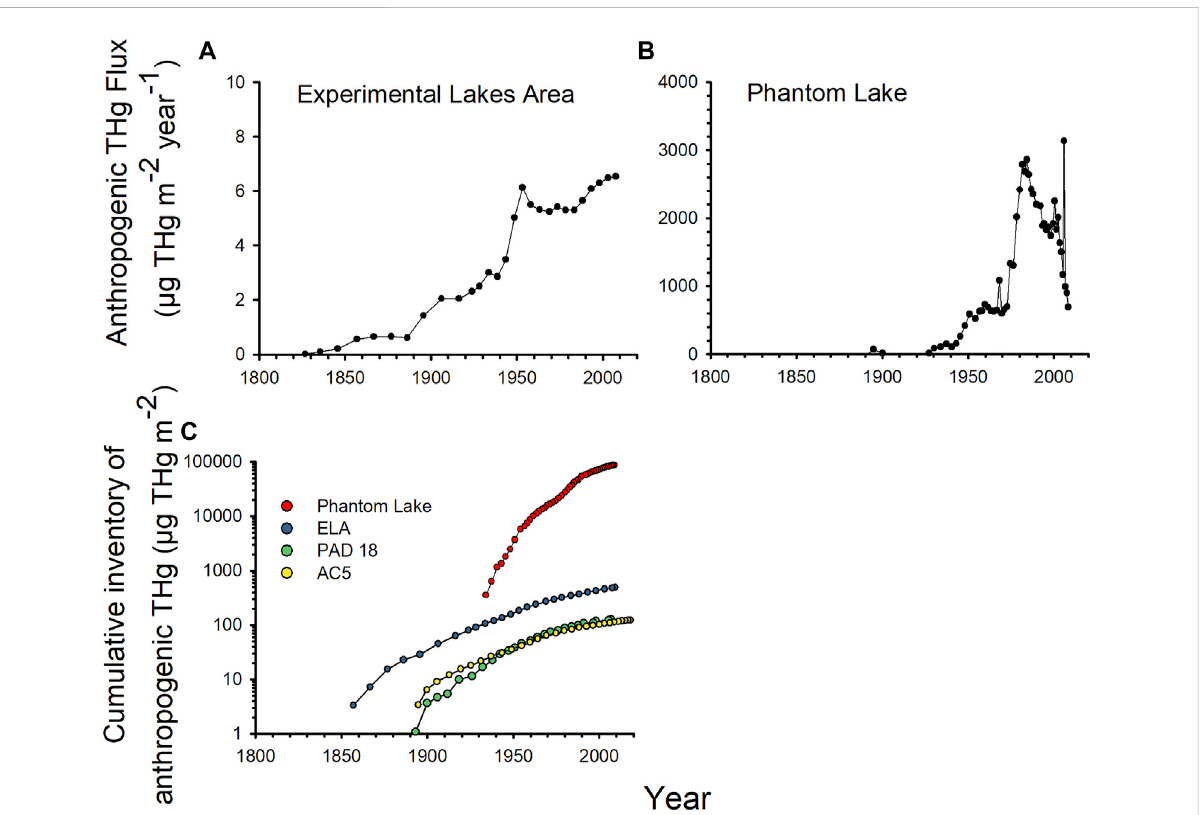
FIGURE 4 Panel (A) isthemeananthropogenicTHg fl uxfrom fi velakes(ELA240,ELA373,ELA377,ELA378andELA442)intheExperimentalLakesAreaof Ontario (Wiklund et al., 2017). Panel (B) is the anthropogenic THg fl ux from Phantom Lake, which is located ~5 km from a smelter in Flin Flon, Manitoba (Wiklund et al., 2017). Panel (C) is the cumulative anthropogenic inventories of THg for Phantom Lake, ELA, PAD 18 and AC5 plotted on a log-scale. The ELA anthropogenic THg inventory is a mean value from the same fi ve lakes as the anthropogenic fl ux